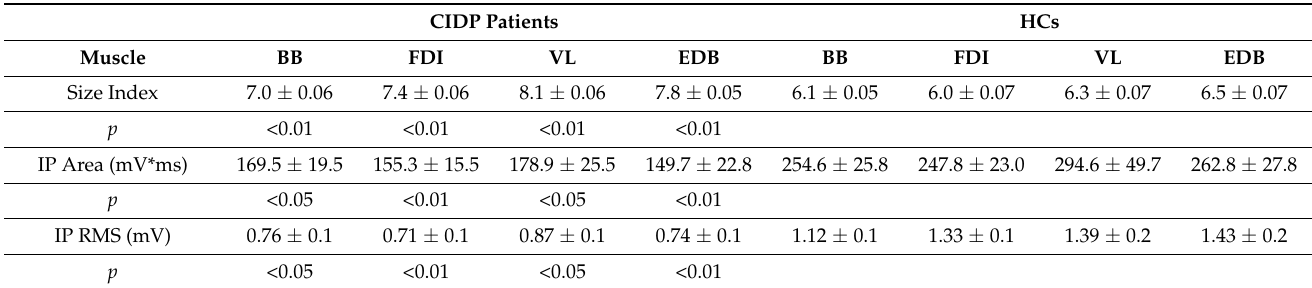
Table legend. CIDP: chronic inflammatory demyelinating polyneuropathy; HCs: healthy controls; BB: brachial biceps; FDI: first dorsal interosseous; VL: vastus lateralis; EDB: extensor digitorum brevis; MUP: motor unit